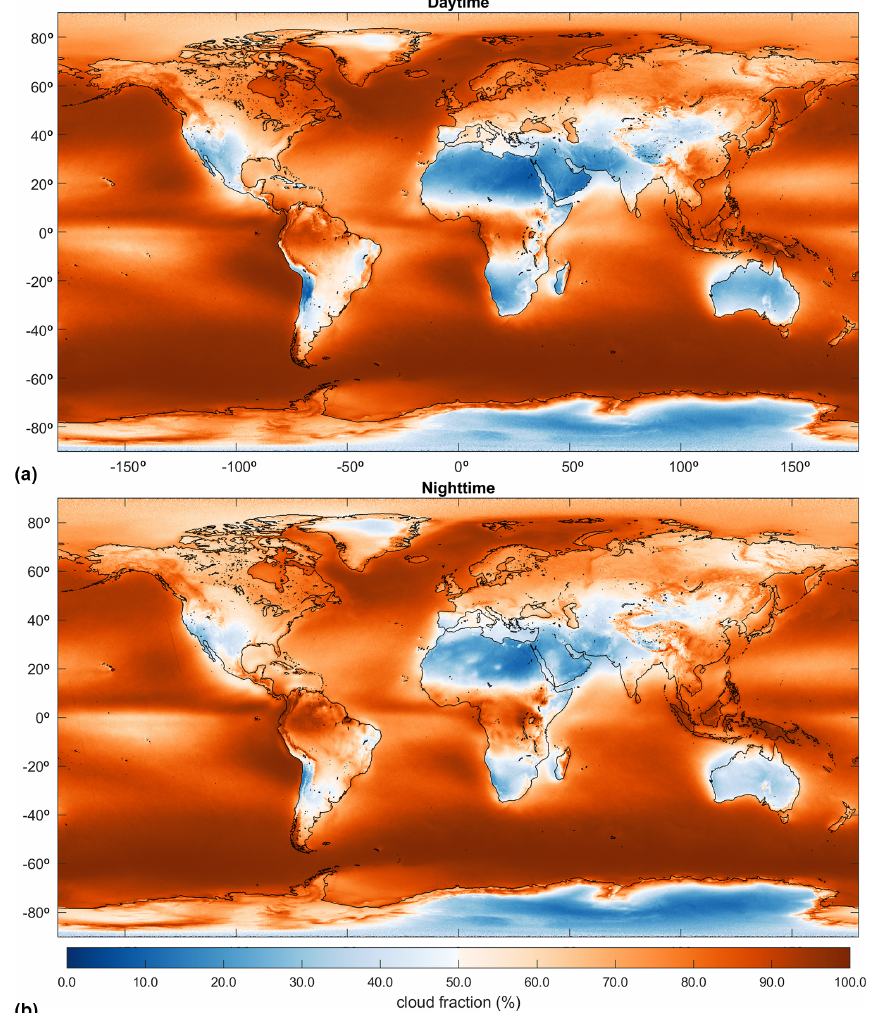
Figure 3. Mean cloud cover (%) calculated using the IASI neural network cloud detection algorithm between 2008 and 2020 separately for day (a) and night (b) observations in a 0.25 ◦ × 0.25 ◦